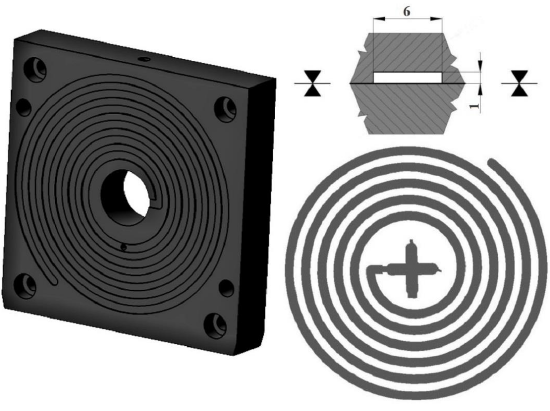
Figure 3. Spiral cavity